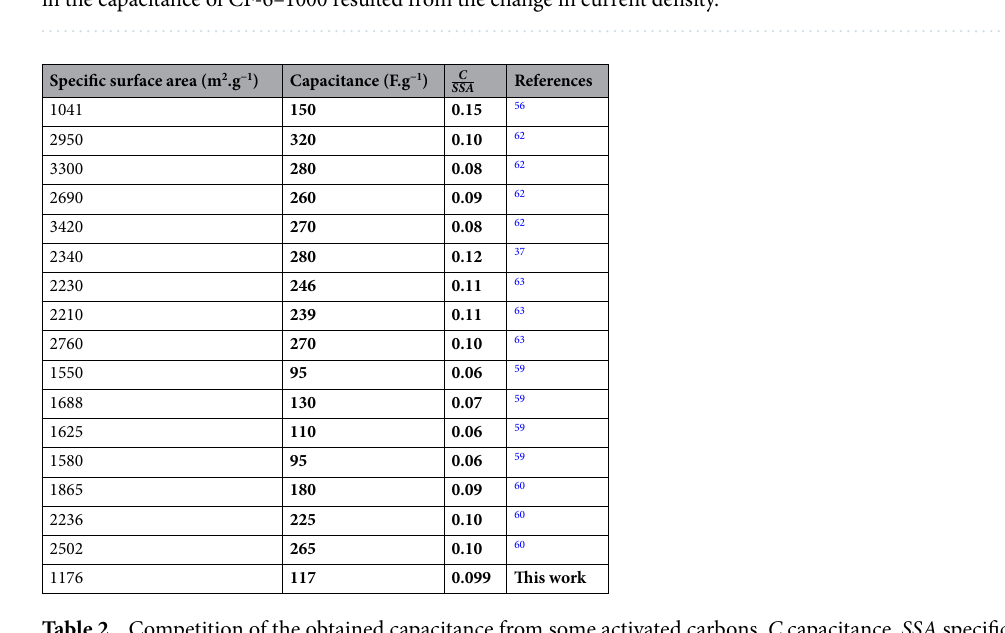
Figure 5. ( a ) Cyclic voltammetry (CV), ( b ) galvanostatic charge–discharge (GCD) of CF-6-1000, ( c ) the change in the capacitance of CF-6–1000 resulted from the change in current density.